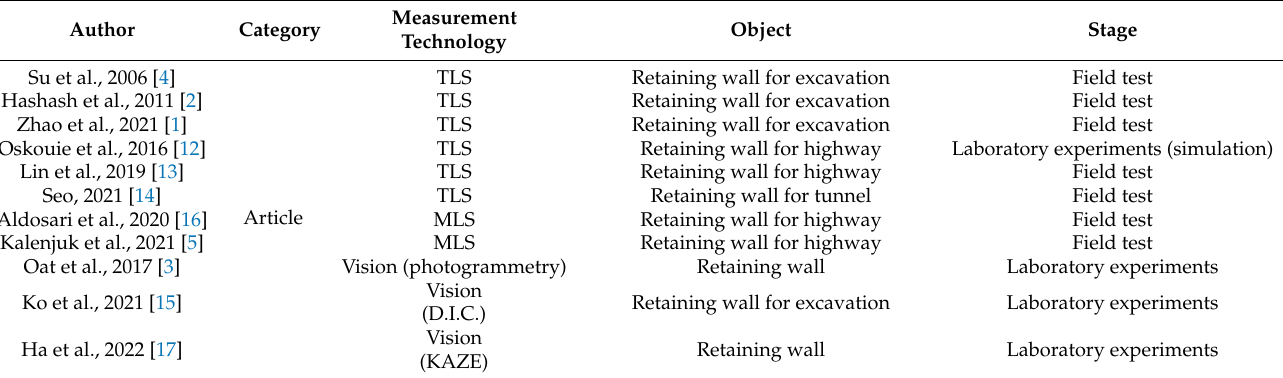
Table 2. Previous studies related to retaining wall displacement measurement using non-contact measurement